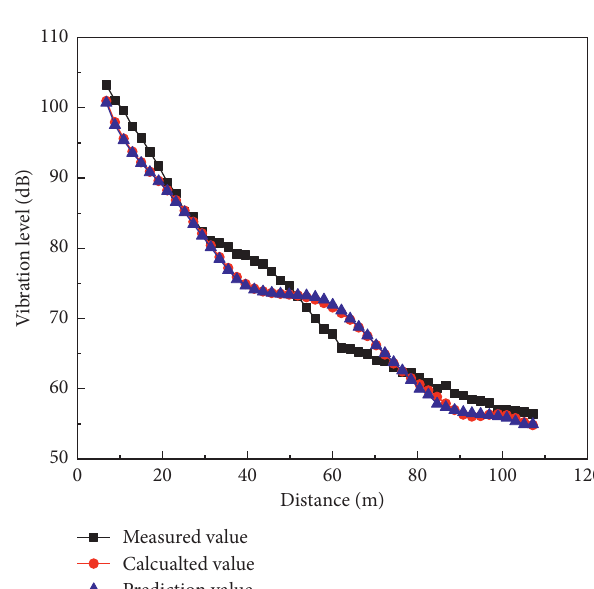
Figure 16: Comparison of the actual measured value, calculated value, and predicted